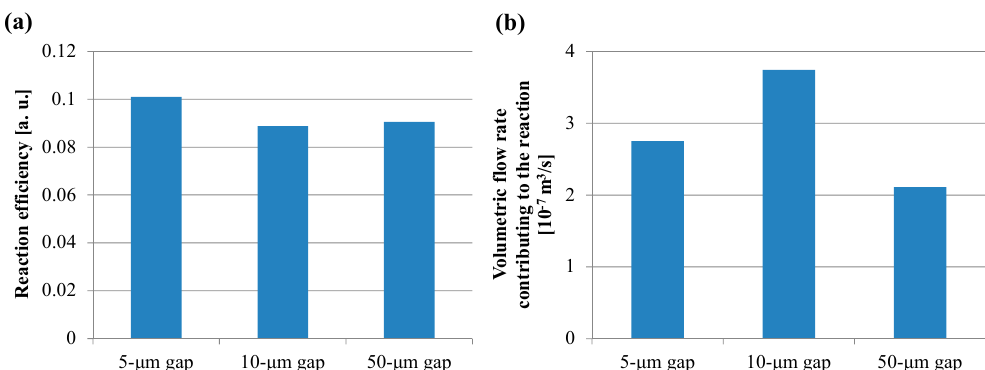
Figure 10. ( a ) Reaction efficiency of the film-stack reaction field calculated using Equation (13). ( b ) Volumetric flow rate contributing to the reaction or adsorption of the biomolecules in the wells with the film-stack reaction field calculated using Equation (14).